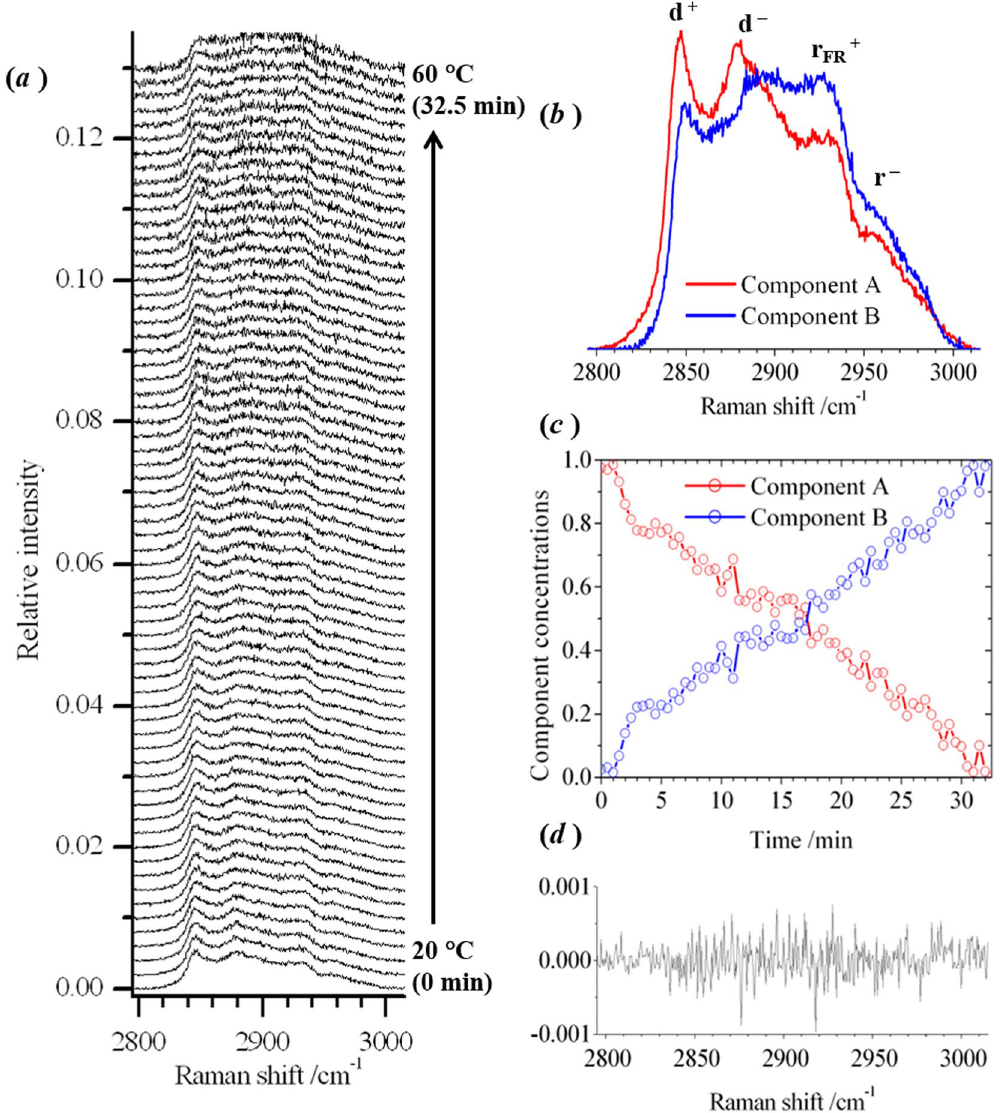
Figure 3. Raman spectra of an optically-trapped POPC/chol/SM liposome, in the region of the C-H stretching band. ( a ) A sequence of experimental Raman spectra recorded at 30 s intervals during a temperature ramp between 20 and 60 °C. ( b ) and ( c ) The pure spectral profiles and concentration profiles for two components obtained by multivariate curve resolution. (d) The residual for the 35 th spectrum, recorded after 17